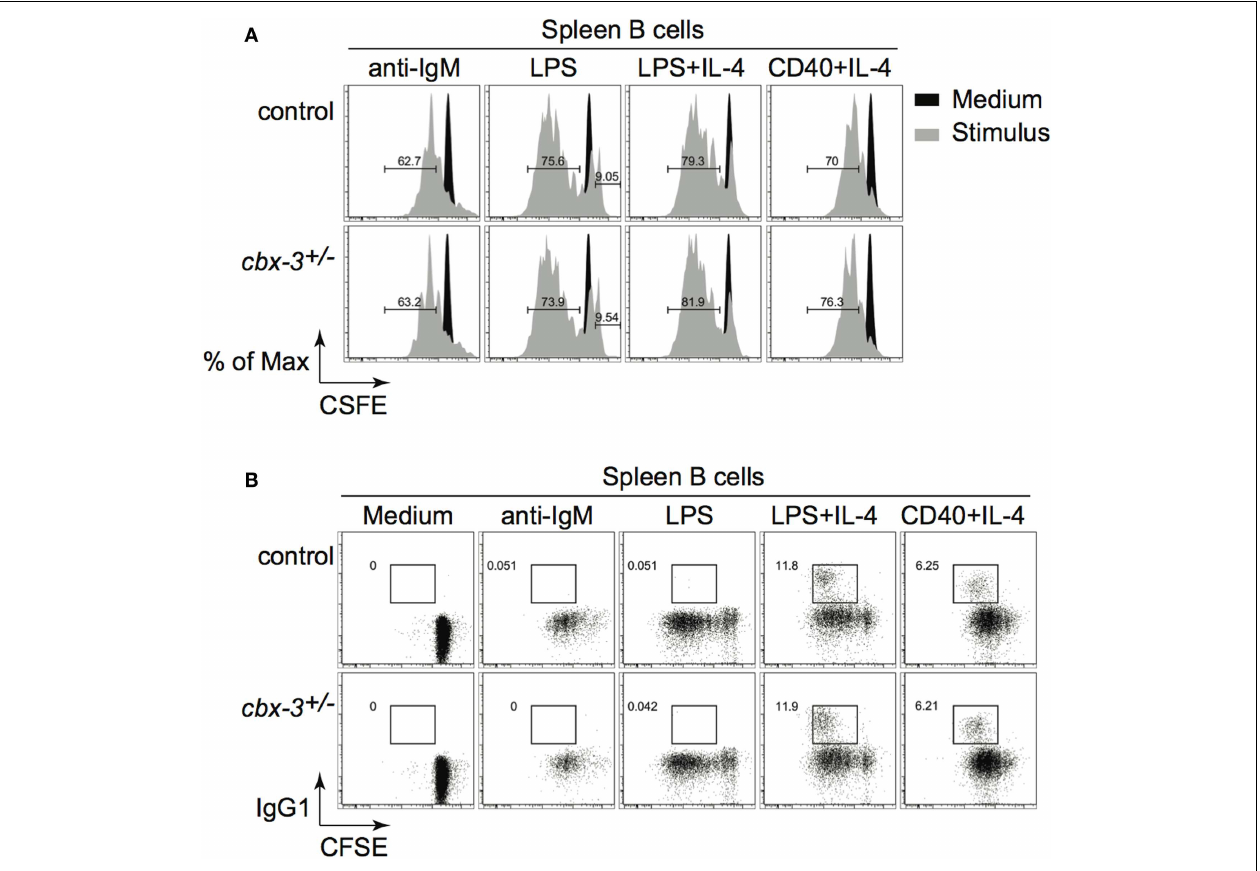
software. (B) IgG 1 switching was determined from the same cultures as in (A) . Results are representative of three independent experiments with six mice per genotype. Analysis was performed on cells derived from the live